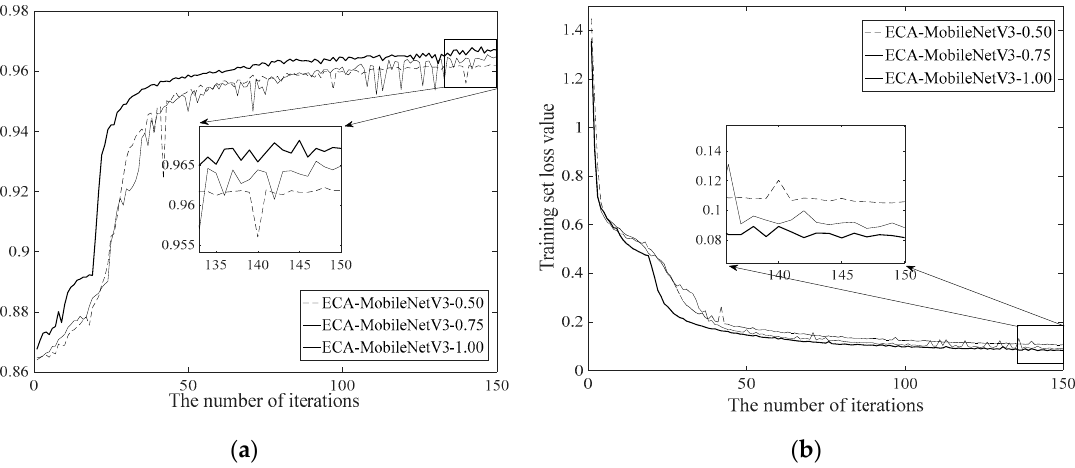
Figure 8. Comparison of loss values and accuracy for different-width multipliers based on the ECA-MobileNetV3 algorithm on Beijing–Tianjin–Hebei airport cluster dataset. ( a ) Accuracy comparison of different-width multipliers. ( b ) Loss value comparison of different-width multipliers.